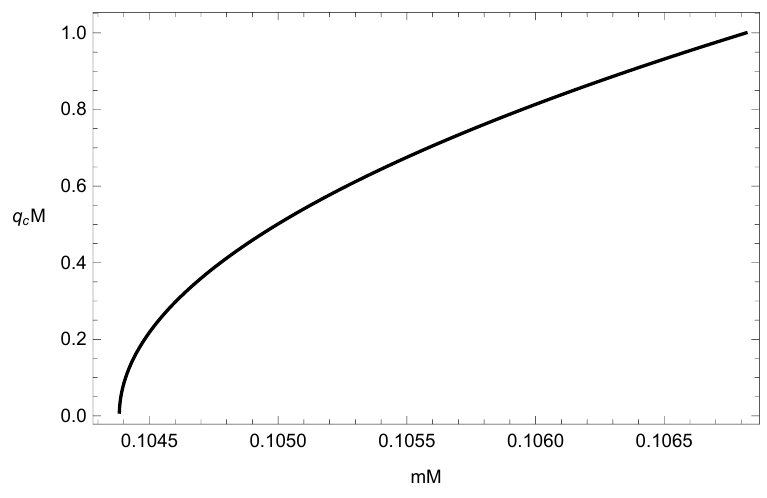
Figure 8 . The behaviour of the critical scalar field charge q c M as a function of mM , with Q/M = 0 . 1 and Λ M 2 = 0 . 01